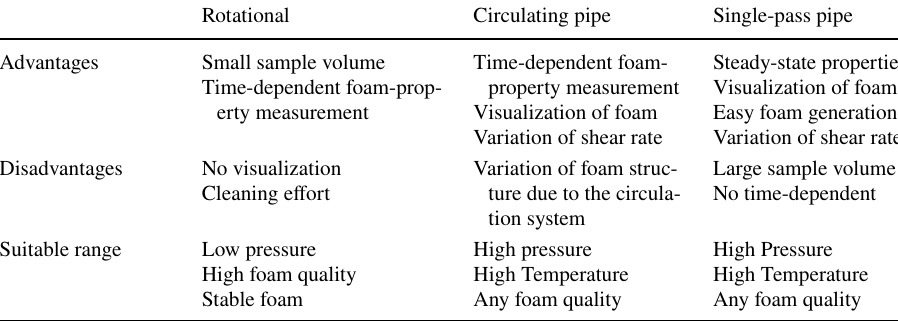
disadvantages, and applications of different rheometer